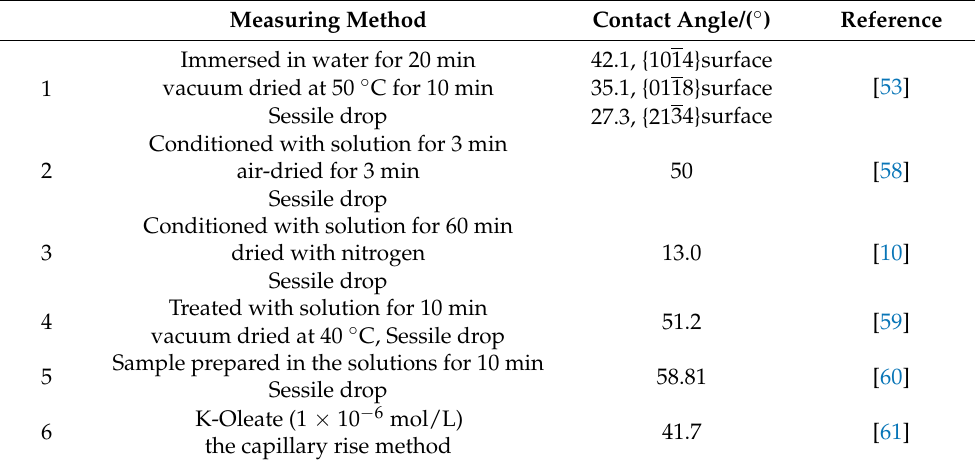
Table 2. A summary of the calcite contact angle reported in the